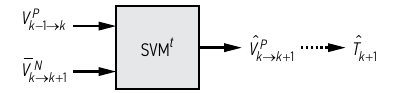
Fig. 3. The structure of the single-stop prediction model